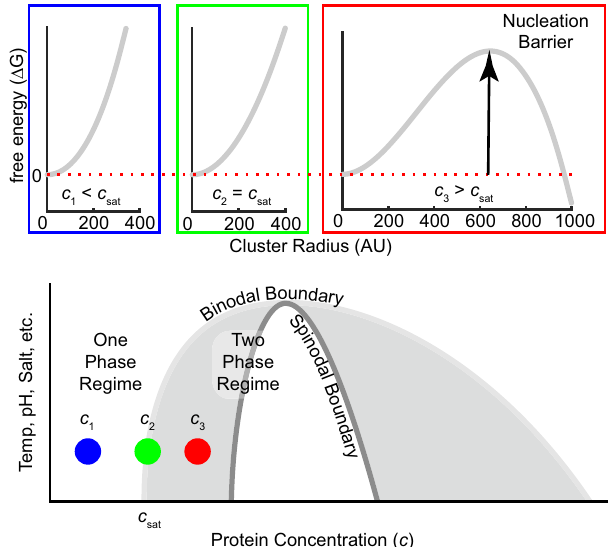
Fig. 1 The free energy barrier to nucleation depends on the degree of supersaturation. The free energy as a function of cluster size is shown on the top for three concentrations, i.e., below, at and above the saturation concentration. As the concentration increases from subsaturated to the saturation concentration to supersaturated, the sign of the free energy difference between a molecule inside and outside a cluster fl ips from positive to negative, and a fi nite nucleation barrier emerges (Eq. (1)). The gray region inside the binodal is metastable, meaning that nucleation is required to form dense phase clusters that grow until equilibrium is reached. The white regime inside the spinodal is unstable, meaning the solution spontaneously decomposes into dilute and dense